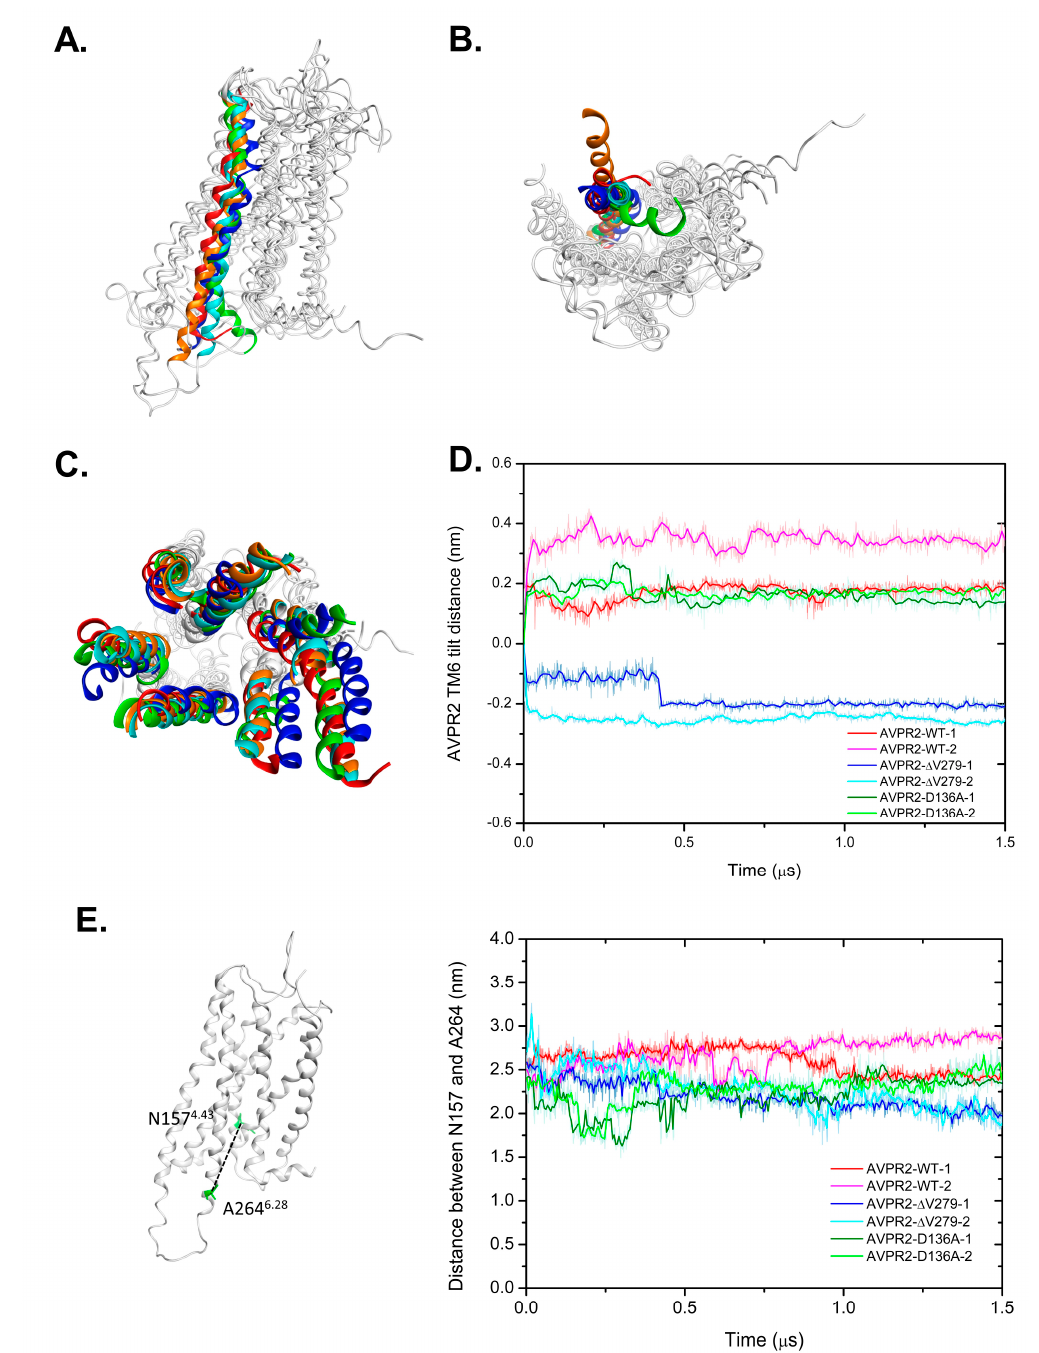
Figure 4. Superposition of TM6 structures in different AVPR2 systems. ( A ) Side view and ( B ) bottom view of the superposition of different AVPR2 systems at final simulation time (1500 ns). Only TM6s at different AVPR2 systems are colored; other regions are in gray. Cyan indicates the initial position of the helix in the simulations; TM6 in red, blue, and green are the positions in AVPR2-WT, AVPR2-D136A, and AVPR2- Δ V279, respectively; TM6 in orange corresponds to the putative activated form. ( C ) The superposition of the extracellular region of different time frames of AVPR2- Δ V279 system (top view). Cyan color: initial time; red color: 500 ns; green color: 1000 ns; blue color: 1500 ns; orange color: active form. ( D ) The change in the tilt distance of TM6 of AVPR2 with time. The C α atom of A264 of TM6 was selected for measurement. ( E ) The profile of transmembrane helices distance with time for different AVPR2 systems. The distance between the C α atoms of A264 of TM6 and N157 of TM4 for each AVPR2 system was measured with time. The dotted line represents the distance between A264 and N157. In ( D ) and (E), two replicates of MD simulations are shown for each AVPR2 system.